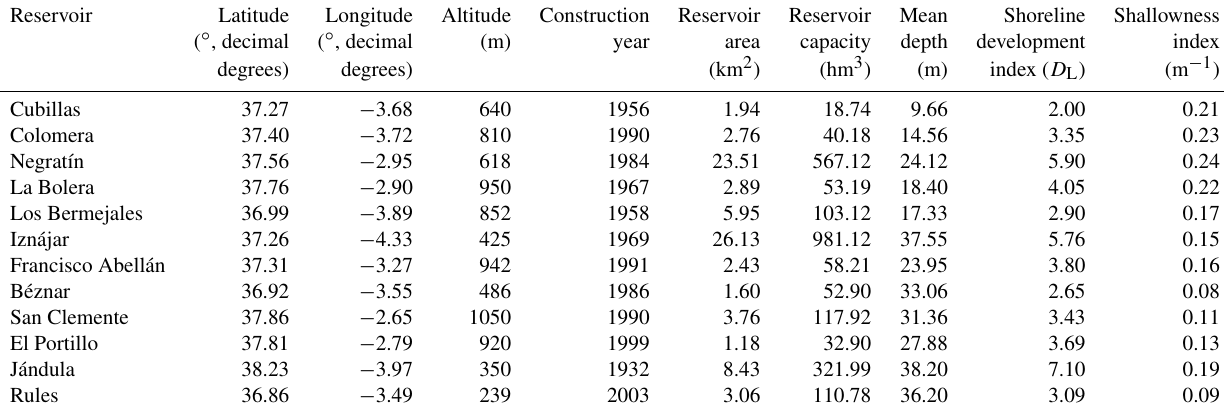
Table 1. Geographical location and morphometric description of the studied reservoirs.